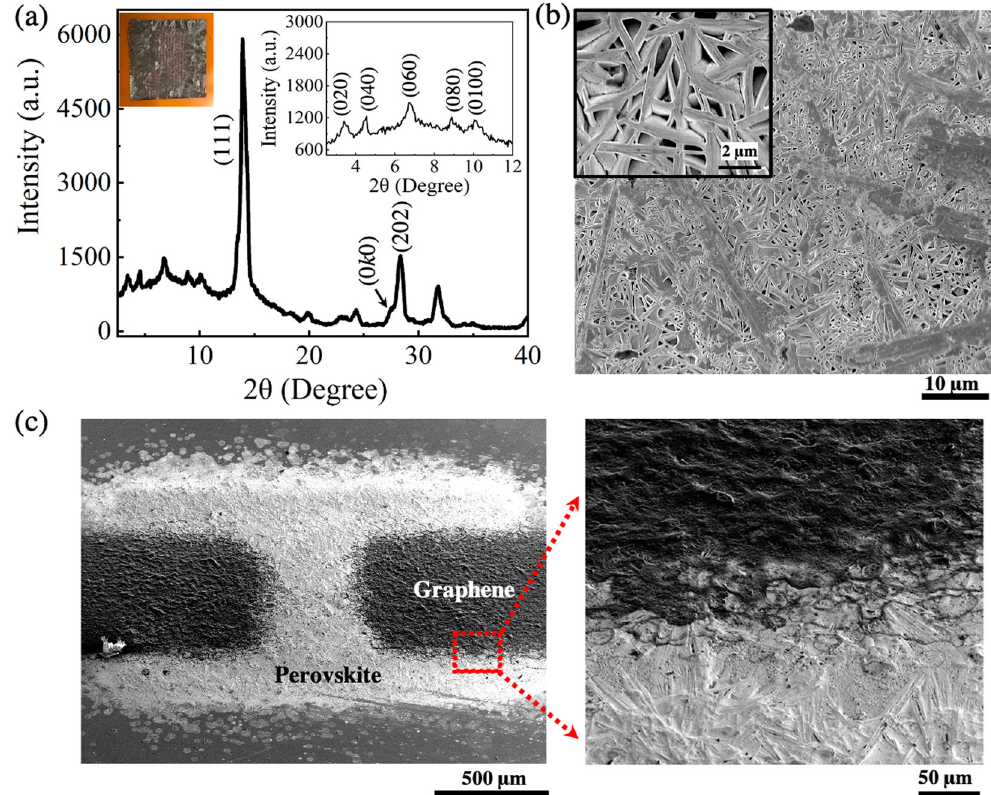
Fig. 2 Material characterization. a The XRD spectra of inkjet-printed 2D perovskite fi lms on SiO 2 /Si substrates. The 2 θ peaks at 13.84° and 28.31° are assigned to the (CH 3 (CH 2 ) 3 NH 3 ) 2 (CH 3 NH 3 ) 3 Pb 4 I 13 (111) and (202) crystallographic planes, respectively. The top-right inset shows low- grazing angle XRD data, that depicts fi ve distinct re fl ections at ~3.4°, 4.5°, 6.7°, 8.9°, and 10° for 2 θ < 14° which is indicative of the number of 2D perovskite layers in the compound. The top-left inset displays the optical microscopy image of the printed perovskite sample on top of the PI substrate over an area ~15 mm 2 used for the XRD analysis. b SEM image of an inkjet-printed perovskite heterostructure PD on a Si substrate. The inset shows the magni fi ed view of the micro fi bular structure of the inkjet-printed 2D perovskites structure, which signi fi cantly increases fi lm roughness and yields a very high photoluminescence 38 . c SEM image at 52° tilt angle of the printed Gr-perovskite PD on a Si substrate, where the right inset displays the Gr-perovskite lateral MS